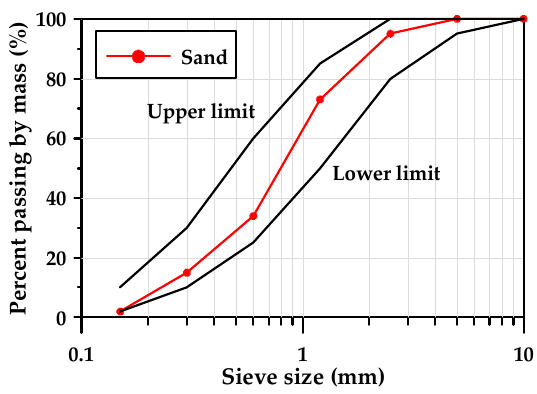
Figure 2. Particle size distribution curve of fine aggregates.